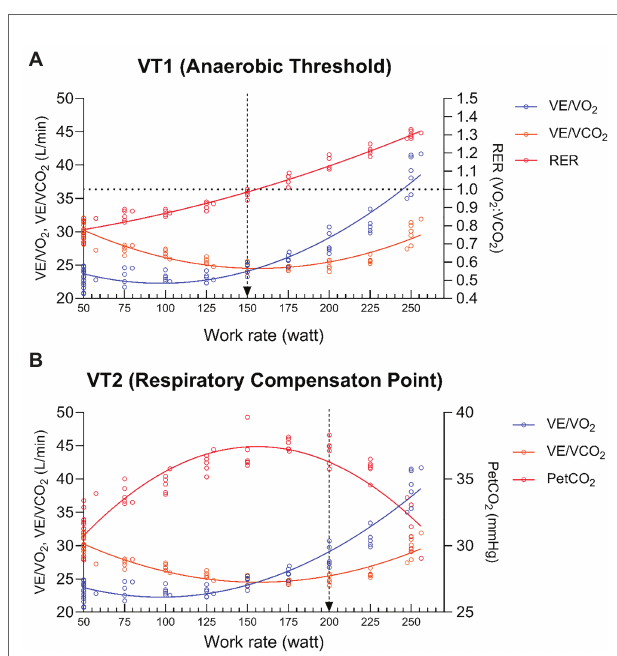
FIGURE 3 | Visual determination of VT 1 (A) and VT 2 (B) . The arrows designate the choice of VT 1 and VT 2 in these sample graphs from